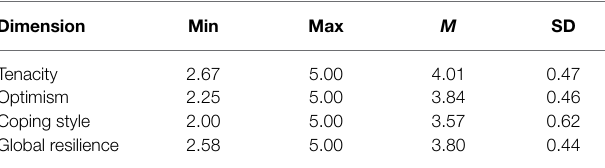
TABLE 3 | The results of the descriptive analysis of English as a foreign language (EFL) teacher resilience.